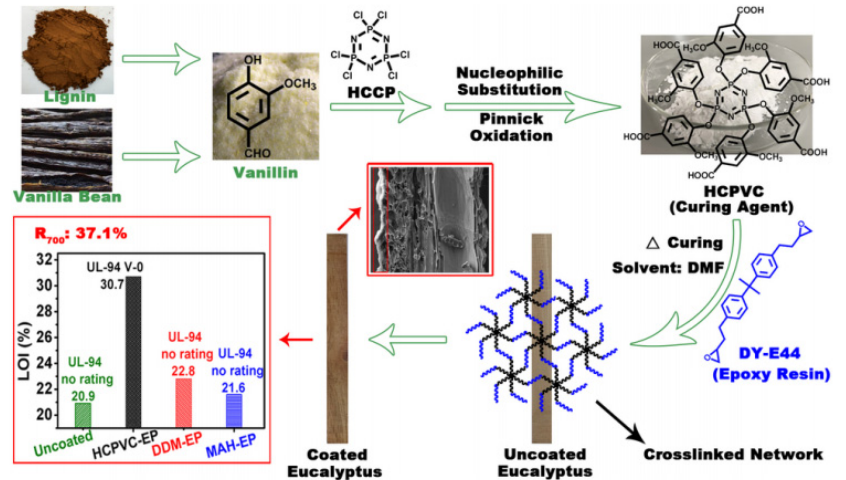
Figure 3. Mechanism diagram of HCPVC curing epoxy resin on the wood surface [61].